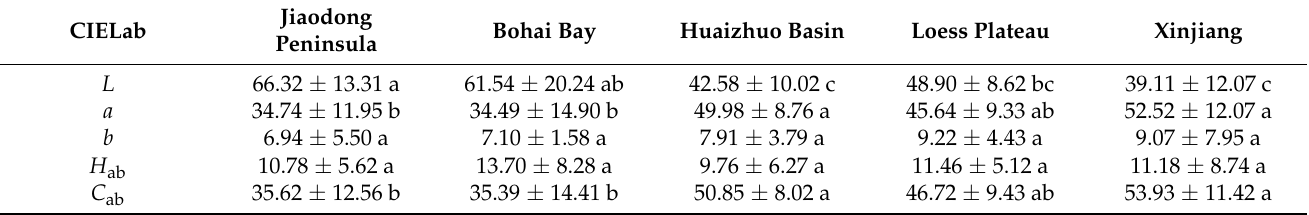
Table 3. CIELab parameters ( L , a , b , H ab , and C ab ) in Marselan wines from different regions in China